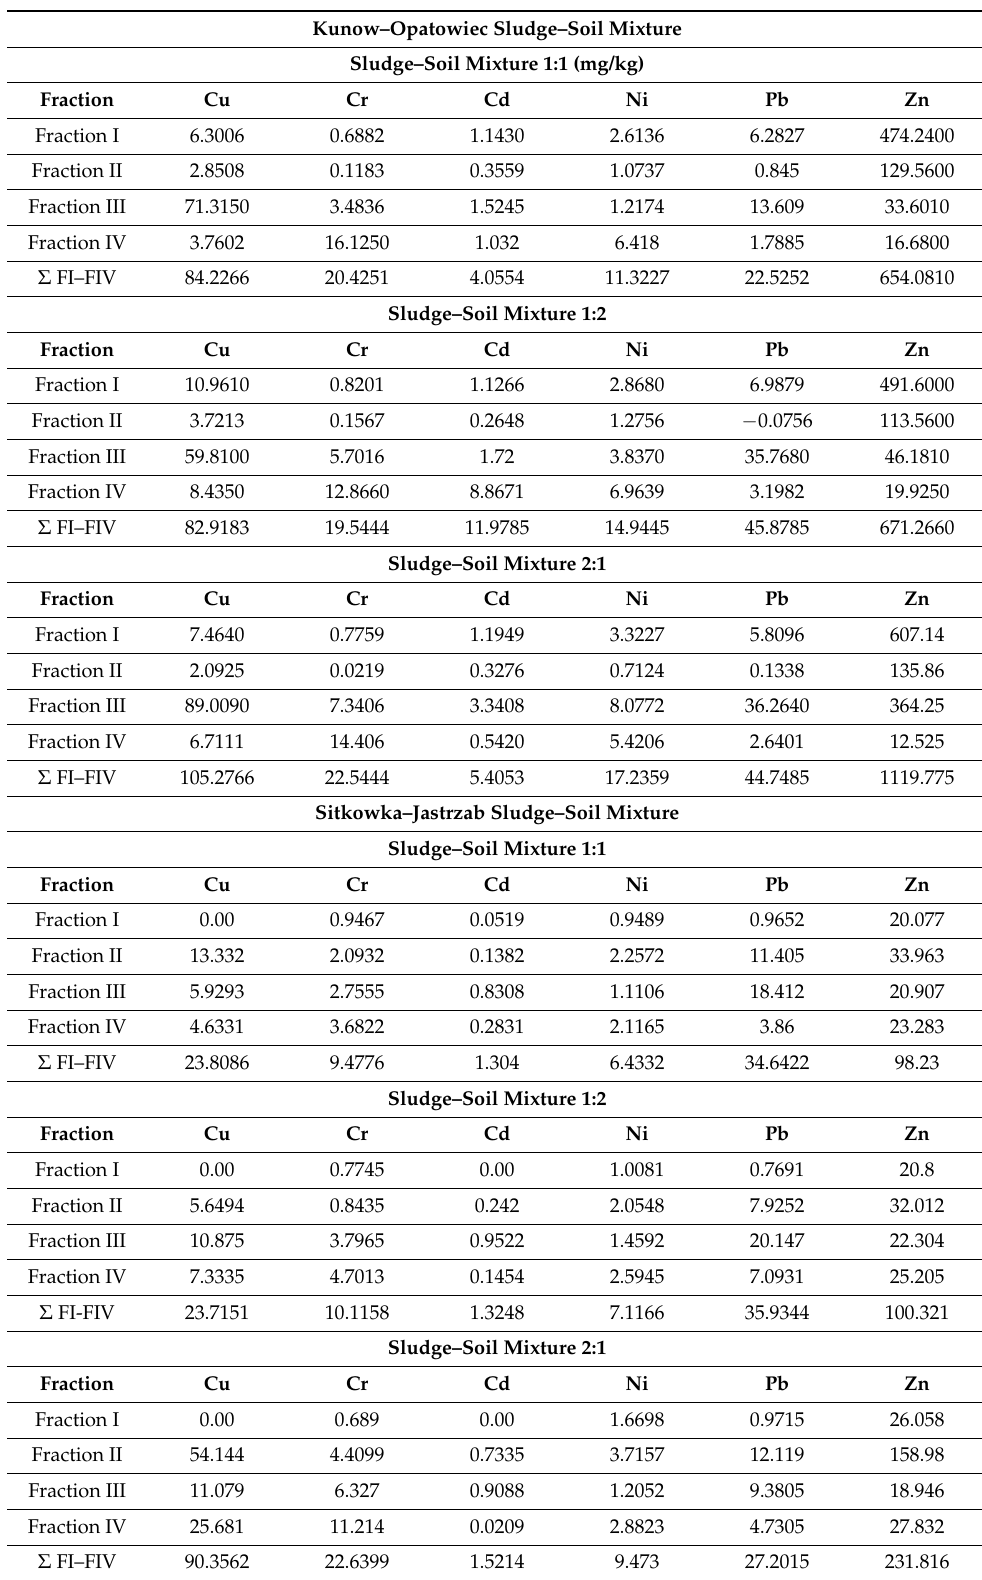
Table 9. Kunow–Opatowiec and Sitkowka–Jastrzab sludge–soil mixtures. Kunow–Opatowiec Sludge–Soil